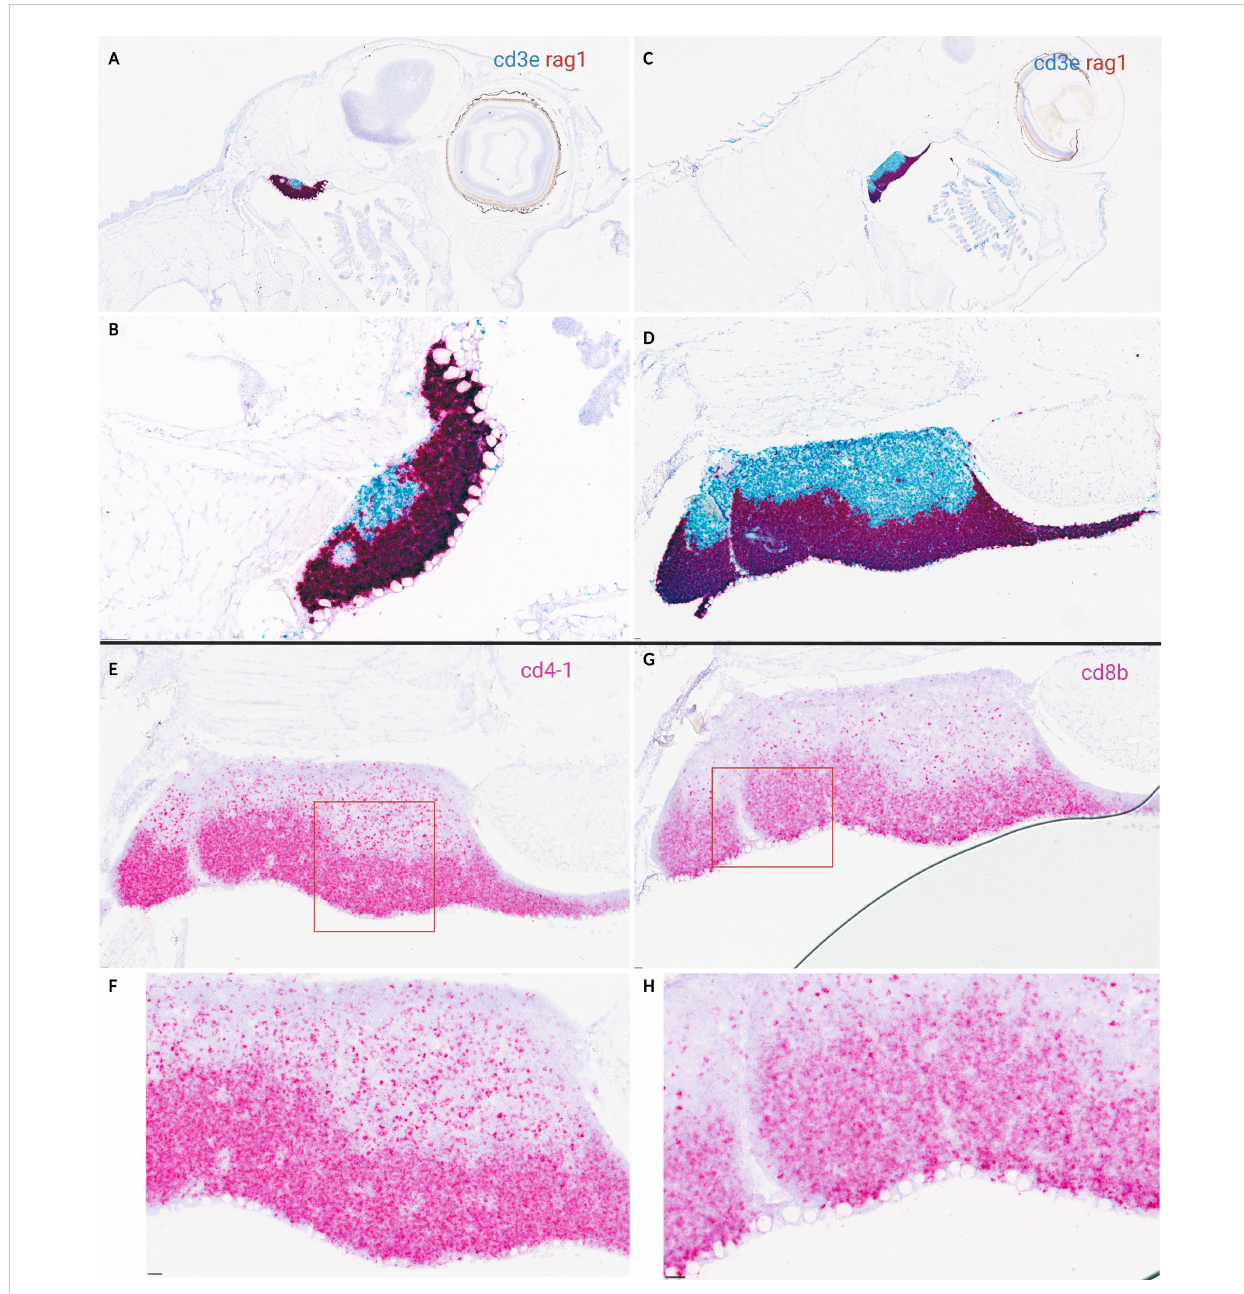
FIGURE 6 In situ hybridization on lateral sections of ballan wrasse thymus in larvae at stage 5 and juveniles. (A-D) shows duplex assays using RAG1(red) and CD3 ϵ (blue) RNA scope probes . (E-H) shows in situ hybridization (single assay) on serial sections of juveniles ’ thymus using either CD4-1probes (E-F) or CD8 b (G-H) probes. (A) Larvae corresponding to early substage 5 (SL: 1,6 cm). (B) Higher magni fi cation of (A) , (C) Juvenile (SL: 3,5 cm). (D) Higher magni fi cation of (C) , (E, G) are juveniles (SL: 3,5 cm), and the area delimited by a red box is shown in higher magni fi cation in (F, H) correspondingly. Scale bars: (B) 50 µm, and (D-H) 25